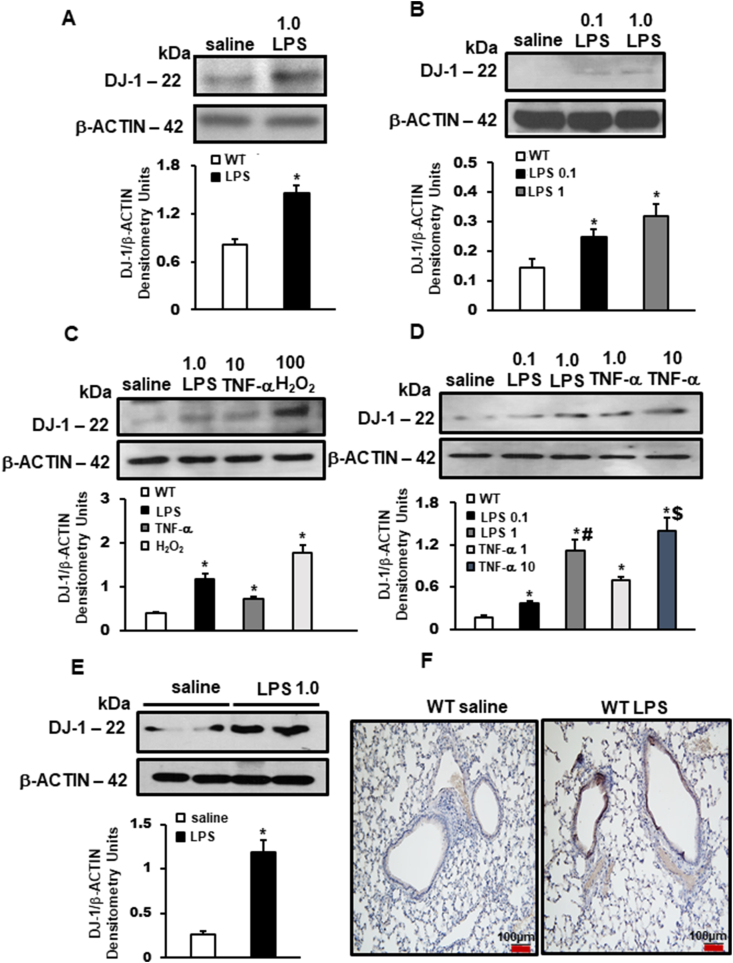
Increased DJ-1 expression in human lung cells and mice following oxidative and inflammatory stimuli. Doses: LPS - μg/mL, TNF-α - ng/mL, H2O2 - μM. Representative western blots showing increased DJ-1 protein expression in A) A549 cells (n = 2 independent experiments), B) HPMEC cells (n = 2 independent experiments), C) Beas-2b cells with different stimuli (n = 3 independent experiments), and D) Beas-2b cells with different doses (n = 3 independent experiments), following stimulation normalized to β-ACTIN protein expression. E) Representative Western blot and showing increased DJ-1 protein expression in whole lung lysates, following LPS stimulation normalized to β-ACTIN protein expression. Densitometry measurements (protein/β-actin) are mean + SEM. *<0.05 vs. saline, #p < 0.05 vs. LPS 0.1, $p < 0.05 vs. TNF-α 1. F) Representative immunohistochemistry images of DJ-1 expression (DAB brown staining) in lungs following 24 h of LPS instillation.